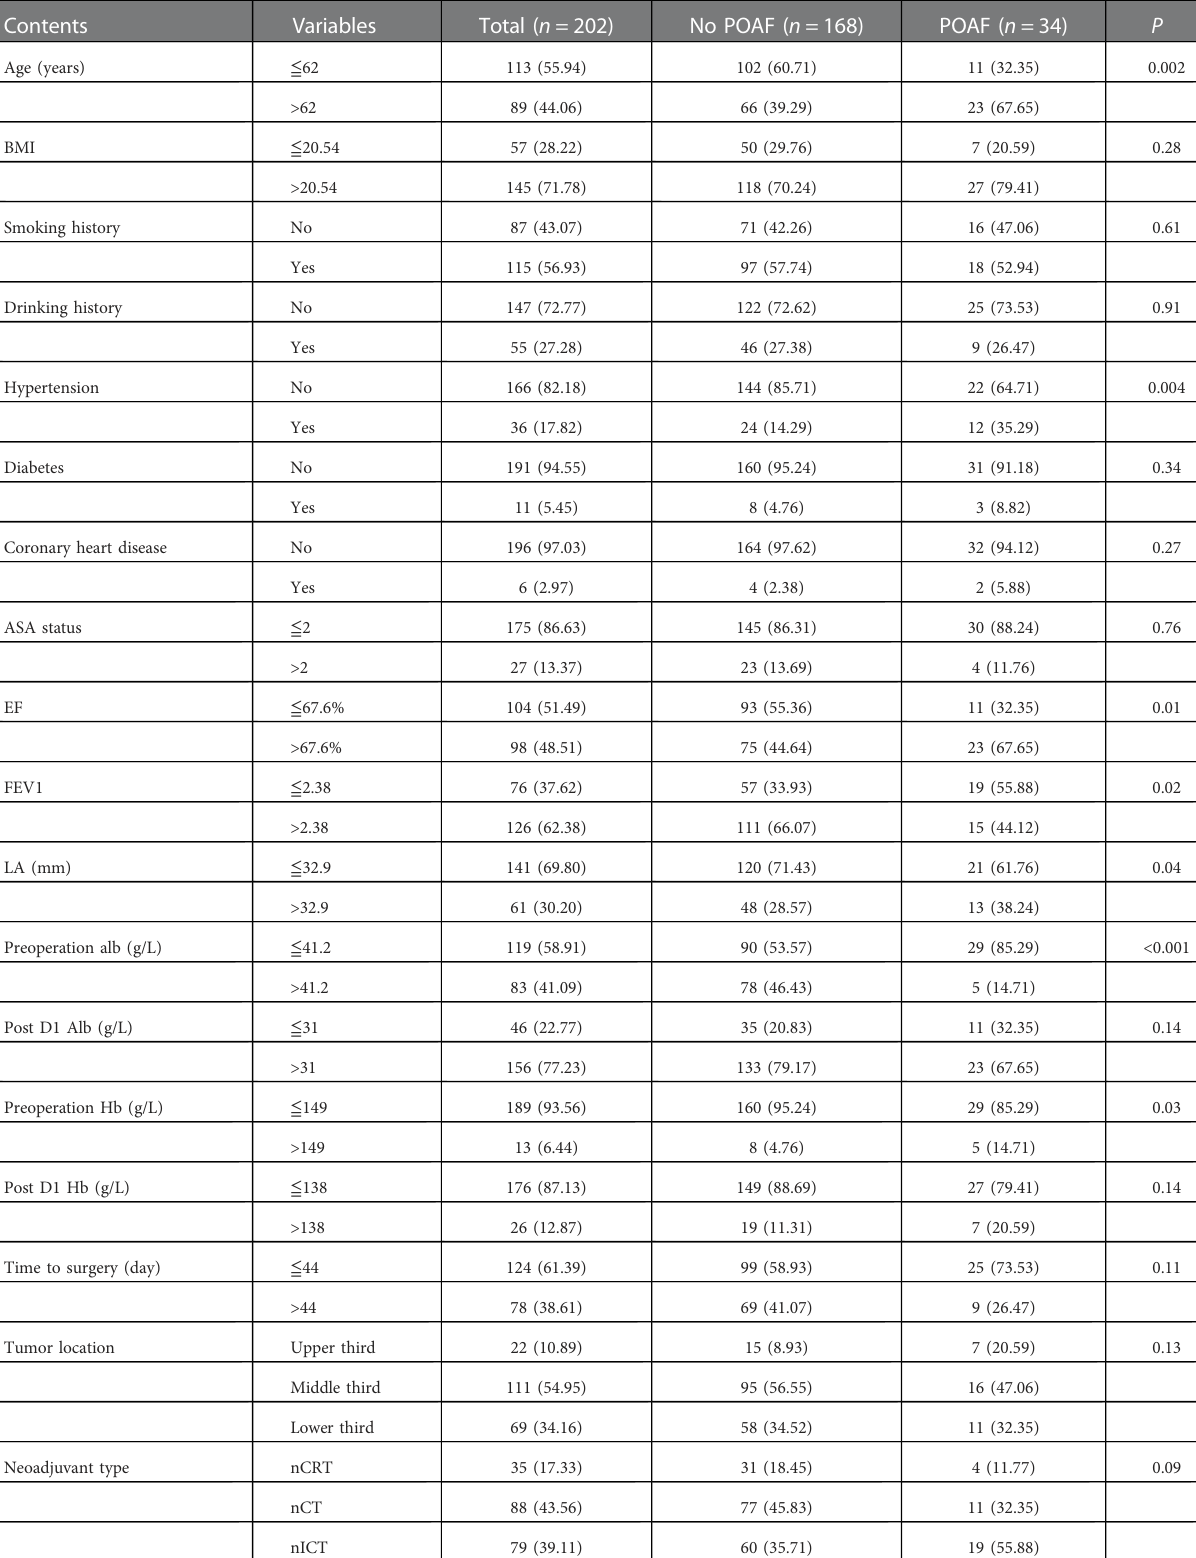
TABLE 1 Comparisons of demographic and clinicopathological characteristics between the POAF group and no POAF